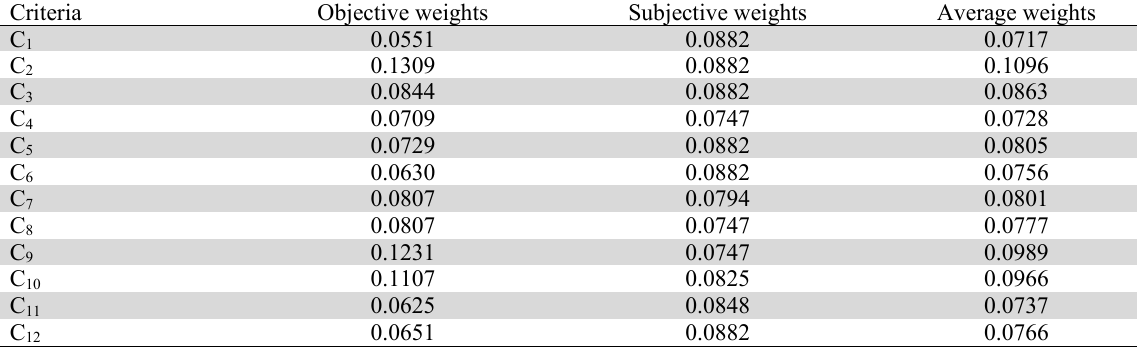
Objective, subjective and average weights for the mini-grid business model criteria